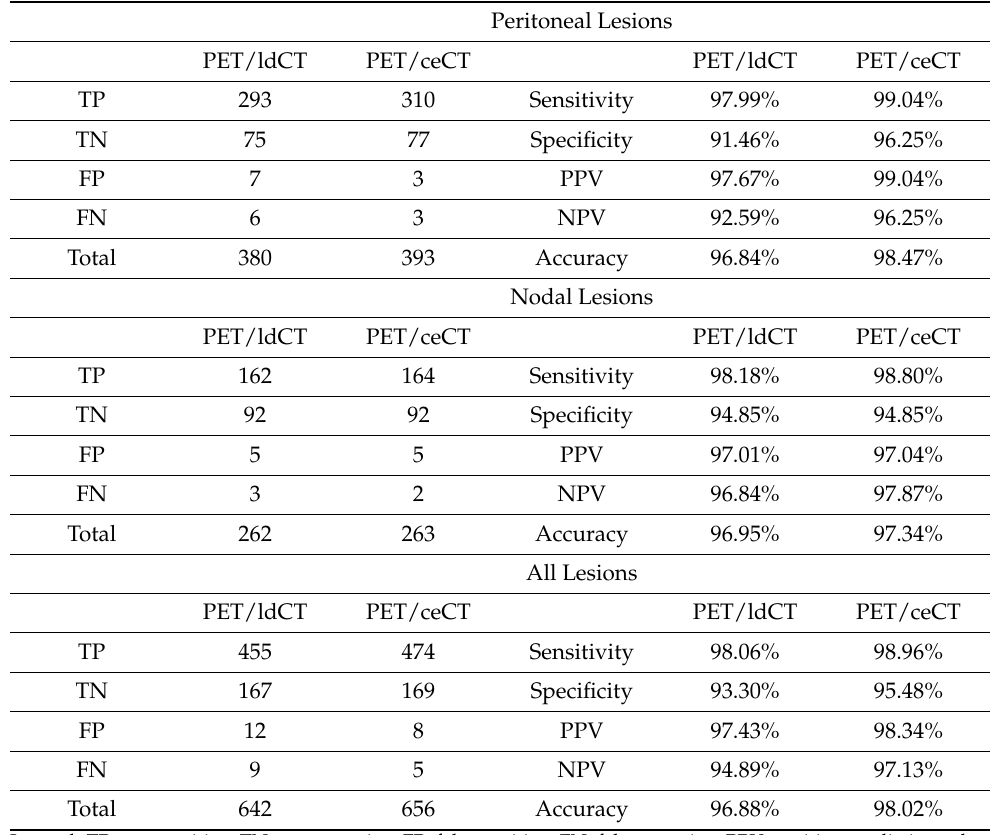
Table 4. Per-lesion analysis of the two diagnostic methods.